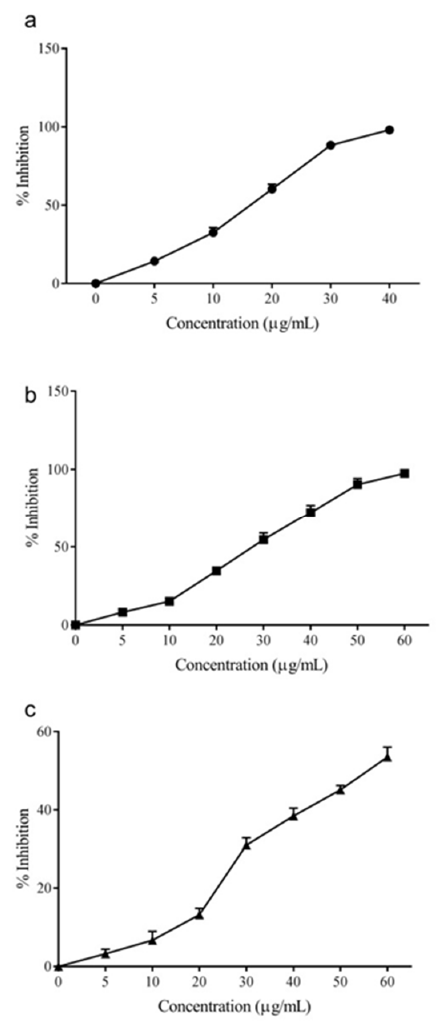
Figure 1. The larvicidal activity of Allspice essential oil against Aedes aegypti ( a ), Culex quinquefascia- tus ( b ), and Armigeres subalbatus ( c ) larvae over 24 h. Table 2. The insecticidal properties of Pimenta dioica (Allspice) essential oil extracted by steam distillation estimated in terms of repellent efficacy, contact toxicity, and fumigant